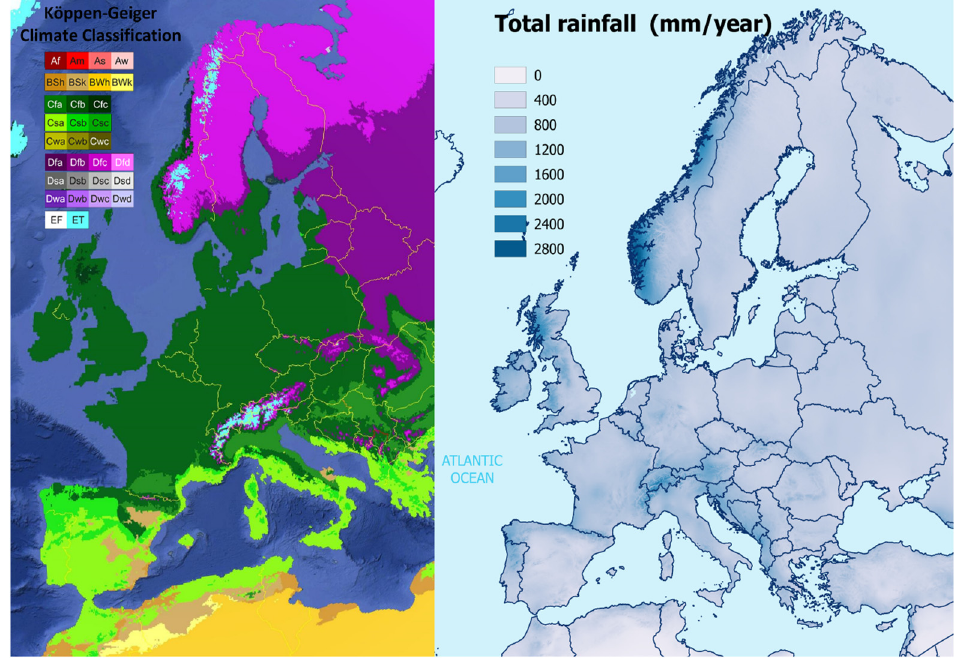
Figure 4. Köppen–Geiger climate classification and annual total rainfall rate of European territory (Maps derived from [79,86]).